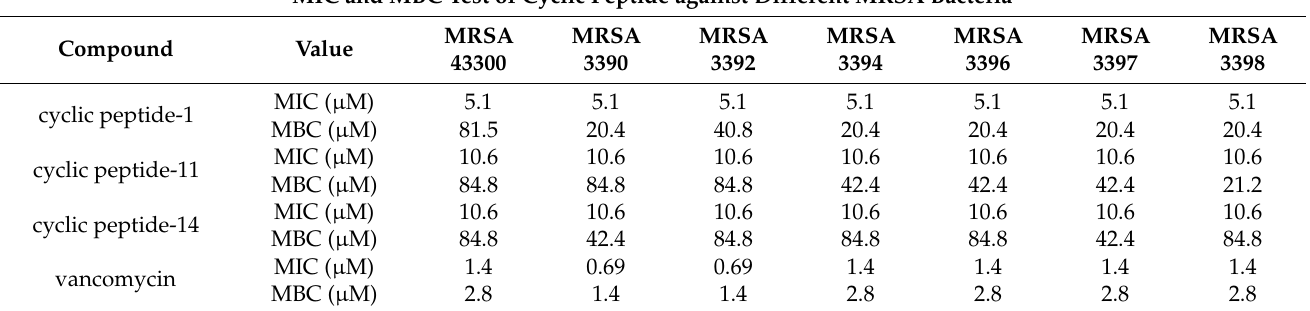
Table 1. MIC and MBC tests of cyclic peptides against different MRSA